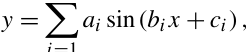
defined as a function of the point spacing. We calculate the average point spacing of the surfaces that make up the rock- fall object and then double the value to determine the voxel size. The size of the voxel is therefore a function of the point spacing and can be adjusted depending on the rockfall ob- ject. The voxel grid is used to provide a spatial context for the rockfall object and allows all points within each voxel to be stored for further analysis. Once the voxel grid is estab- lished, for each voxel grid line in the XY and XZ planes, we calculate the maximum Euclidean distance between points within populated voxels (Fig. 6e). The calculated distances are plotted along each grid line. Curves are then fit to each of the distributions, utilizing a Fourier series fit, a Gaussian fit and a sum of sines fit. An overview of each of the fitting methods is provided